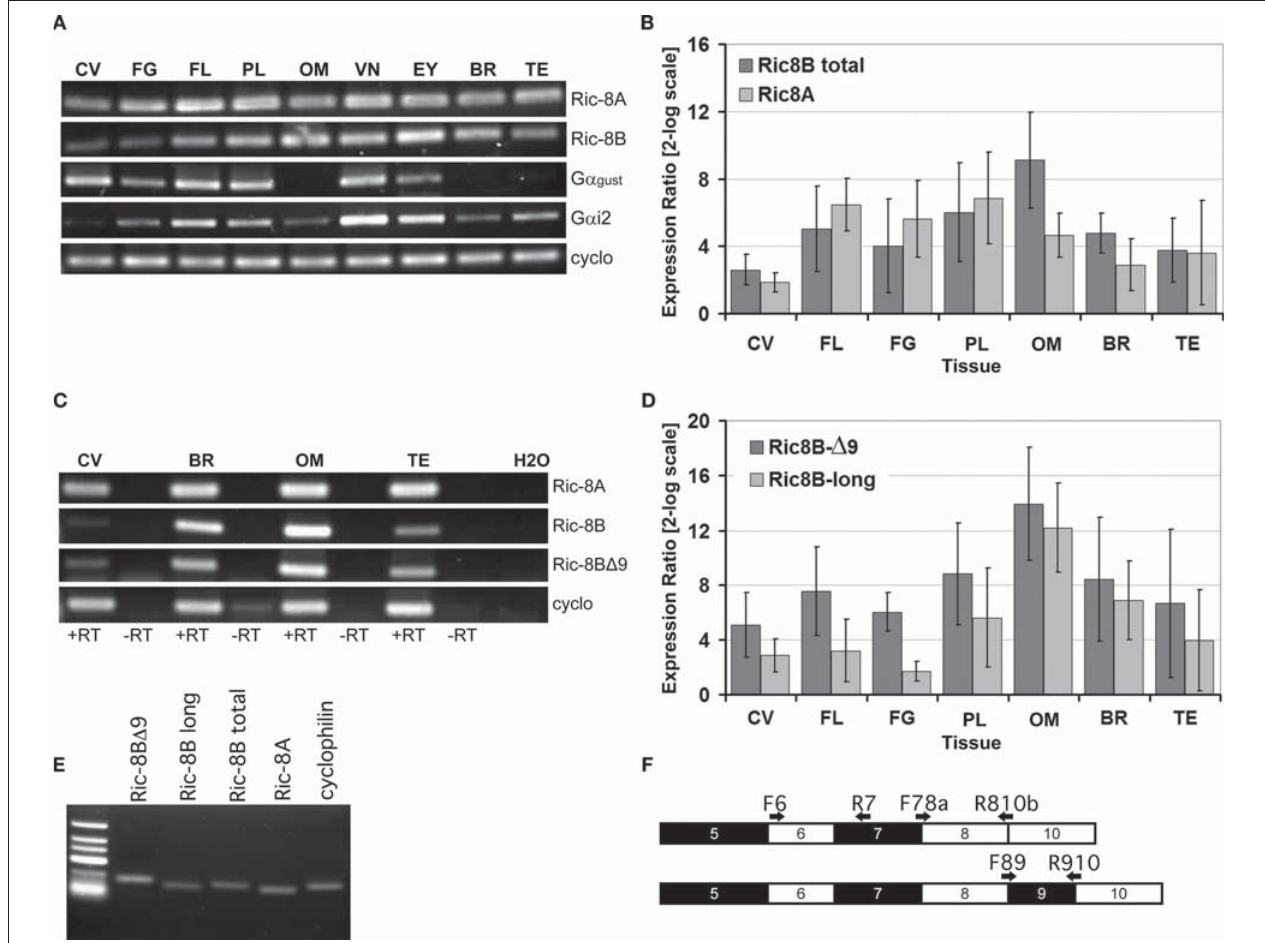
FIGURE 1 | Ric-8A and Ric-8B variants are expressed in tongue taste papillae. (A) RT-PCR on total RNA from various tissues using specifi c primers for Ric-8A, Ric-8B, gustducin, G α i2 and cyclophilin. CV: circumvallate papillae, FG: fungiform papillae, FL: foliate papillae, PL: Palate, OM: olfactory mucosa,